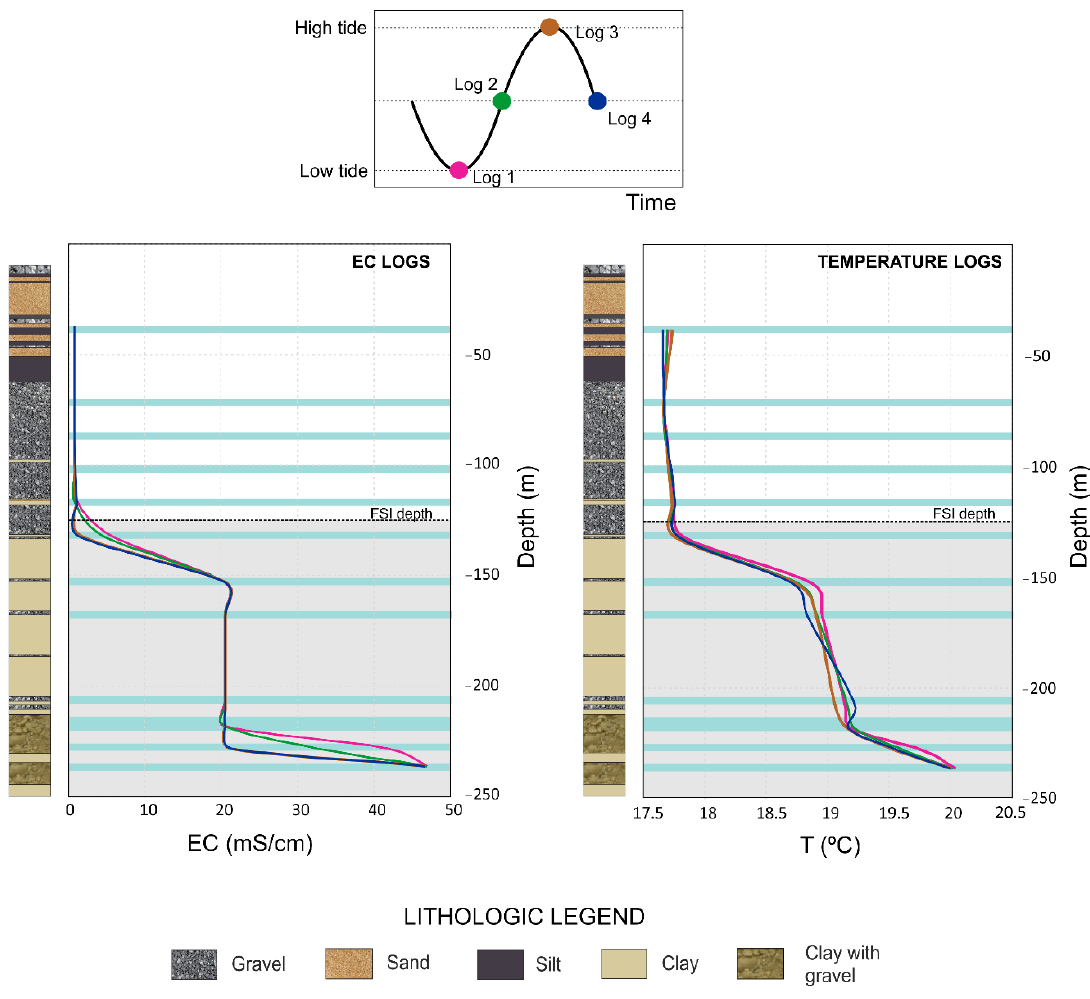
Figure 7. Vertical logs of EC and T in well W250 during a tidal cycle and the position of the FSI (grey area) and location of the screens (grey bars) where the measurements were obtained (30th September 2019). Log 1 (pink line) during low tide, Log 2 (green line) during tidal rise, Log 3 (brown line) during high tide and Log 4 (blue line) during tidal fall.